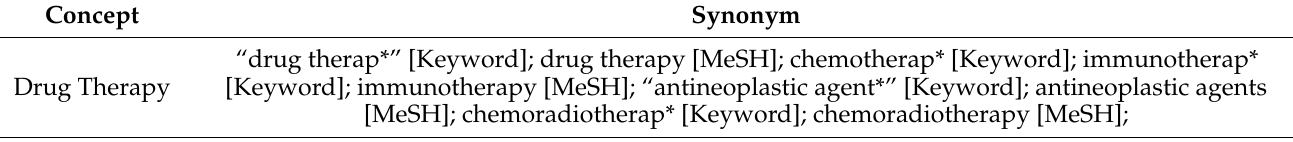
Table A1. Drug Therapy (Chemotherapy, Immunotherapy, etc.) for the Treatment of Solid Tumour Cancers. Search Planning